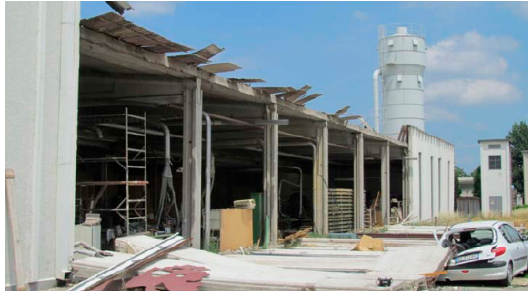
Figure 2. Collapse of infill panels [1].